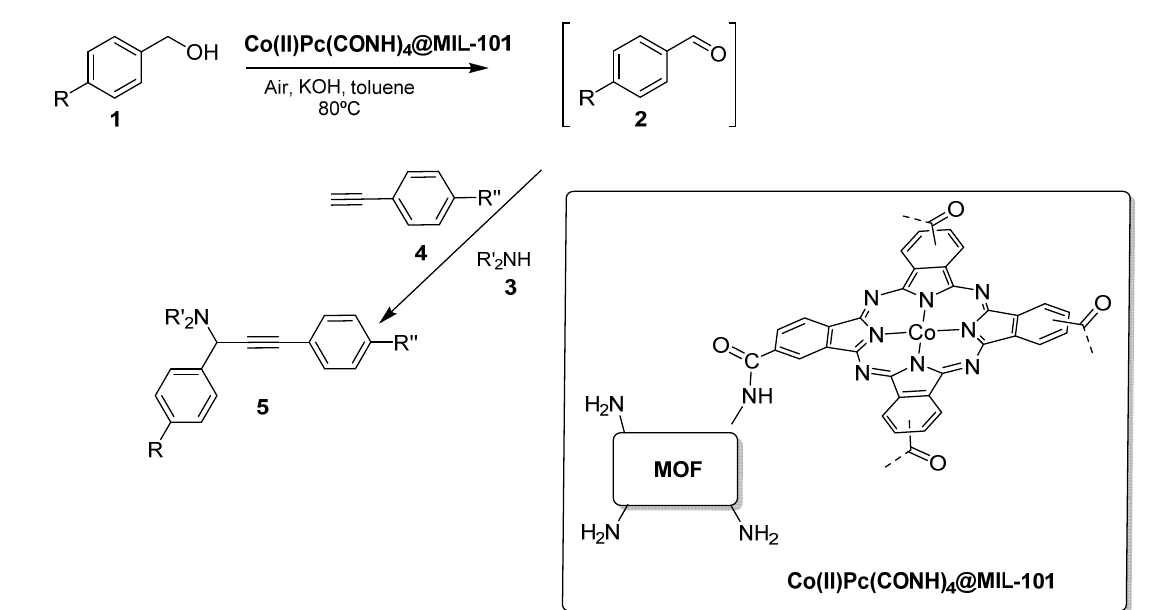
Figure 31. Synthesis of propargylamines via tandem oxidative A3 coupling reaction of benzyl alcohols using Co(II)Pc(CONH) 4 @MIL-101 (adapted from [81]).